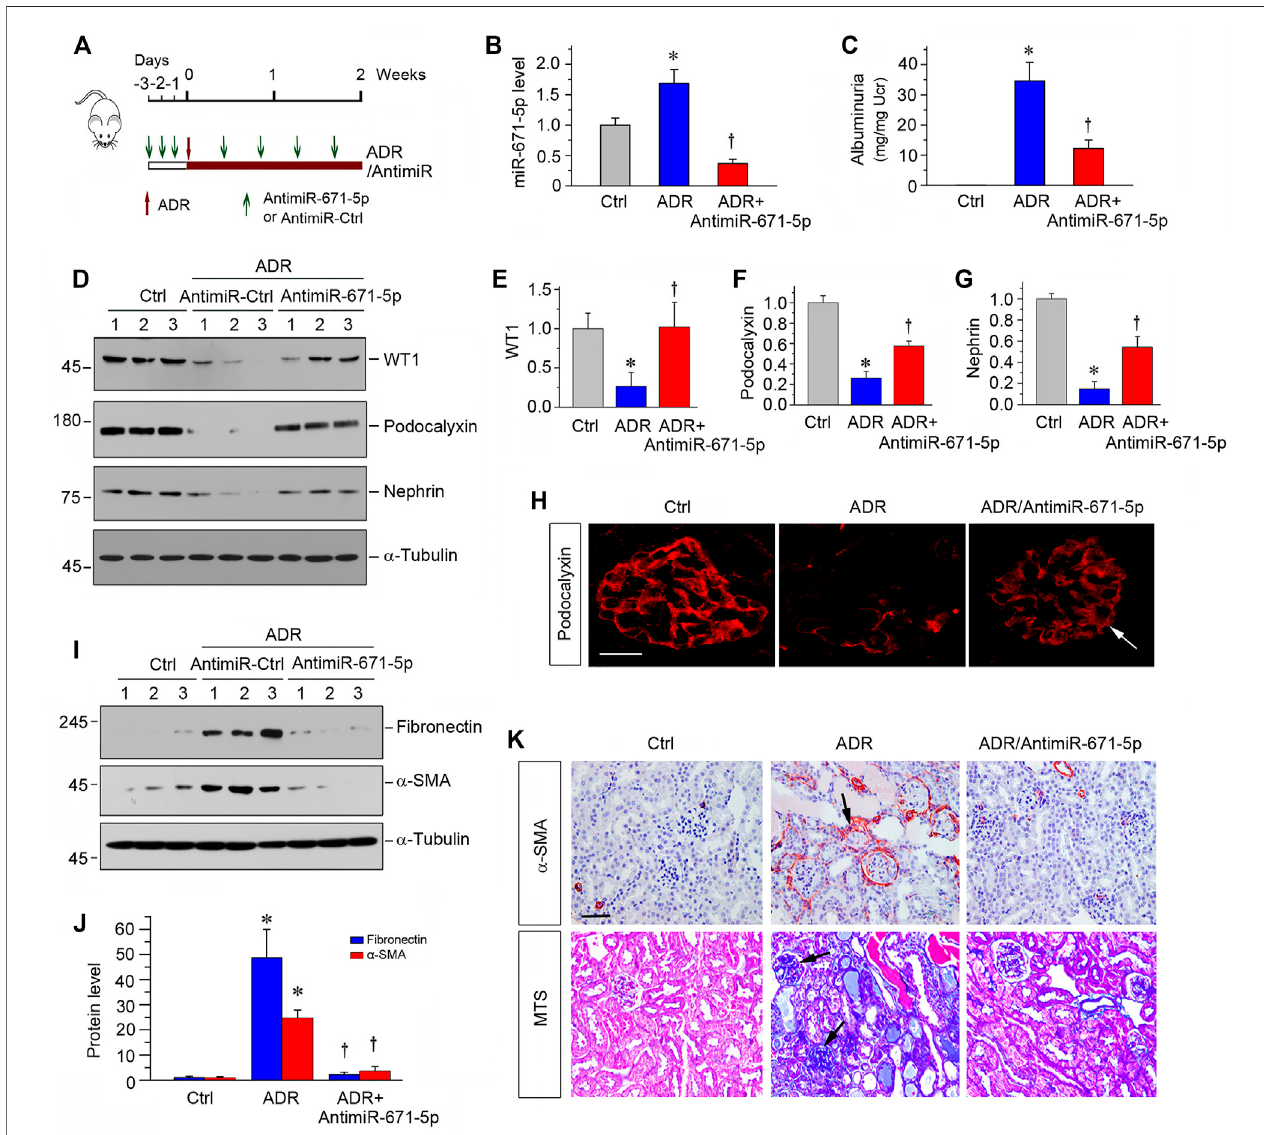
FIGURE 6 | Inhibition of miR-671-5p reduces proteinuria and renal fi brotic lesions in ADR nephropathy. (A) Experimental design. Red Arrows indicate the time of ADR injection. Green arrows indicate the different time points of antagomir injections. (B) qRT-PCR analysis shows that miR-671-5p level was increased in ADR group comparedwithcontrol,andinjectionsofantimiR-671-5pdecreasedmiR-671-5plevel.* p < 0.05versusnormalcontrols; † p < 0.05versusADR( n (cid:1) 5 – 6). (C) Inhibitionof miR-671-5p reduces proteinuria in ADR nephropathy. Urinary albumin levels were assessed in mice at 2 weeks after ADR injection and expressed as mg/mg creatinine.* p < 0.05versusnormalcontrols; † p < 0.05versusADR( n (cid:1) 5 – 6). (D – G) RepresentativeWesternblots (D) andgraphicpresentationsofWT1 (E) ,podocalyxin (F) and nephrin (G) werepresented.* p < 0.05versusnormal controls, † p < 0.05versusADRalone ( n (cid:1) 5 – 6). (H) Immuno fl uorescencestainingshowsthatantimiR-671- 5p preserved renal podocalyxin expression in ADR nephropathy. Arrow indicate positive staining. Scale bar, 20 µm. (I,J) Representative Western blots (I) and graphic presentations of fi bronectin and α -SMA (J) were presented. * p < 0.05 versus normal controls, † p < 0.05 versus ADR alone ( n (cid:1) 5 – 6). (K) Representative micrographs show that antimiR-671-5p inhibited α -SMA expression (upper panel) and renal fi brotic lesions (bottom panel) in different groups as indicated. Scale bar, 50 µm.